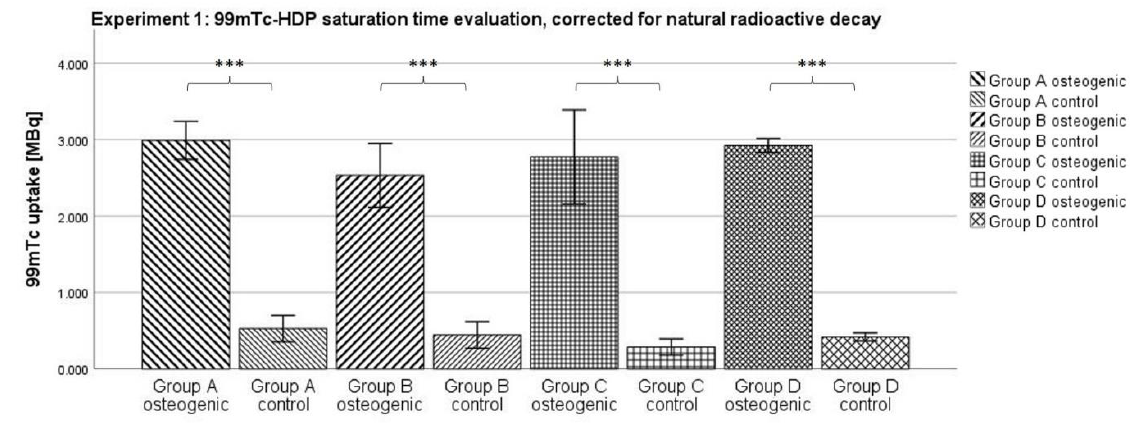
Figure 1. Mean 99m Tc-HDP uptake as measured by the dose calibrator when testing for the saturation time. The error bars show the standard deviation. Stars indicate significant differences between the two groups connected by a bracket. *** = significance 𝑝 ≤ 0.001 . n = 6.